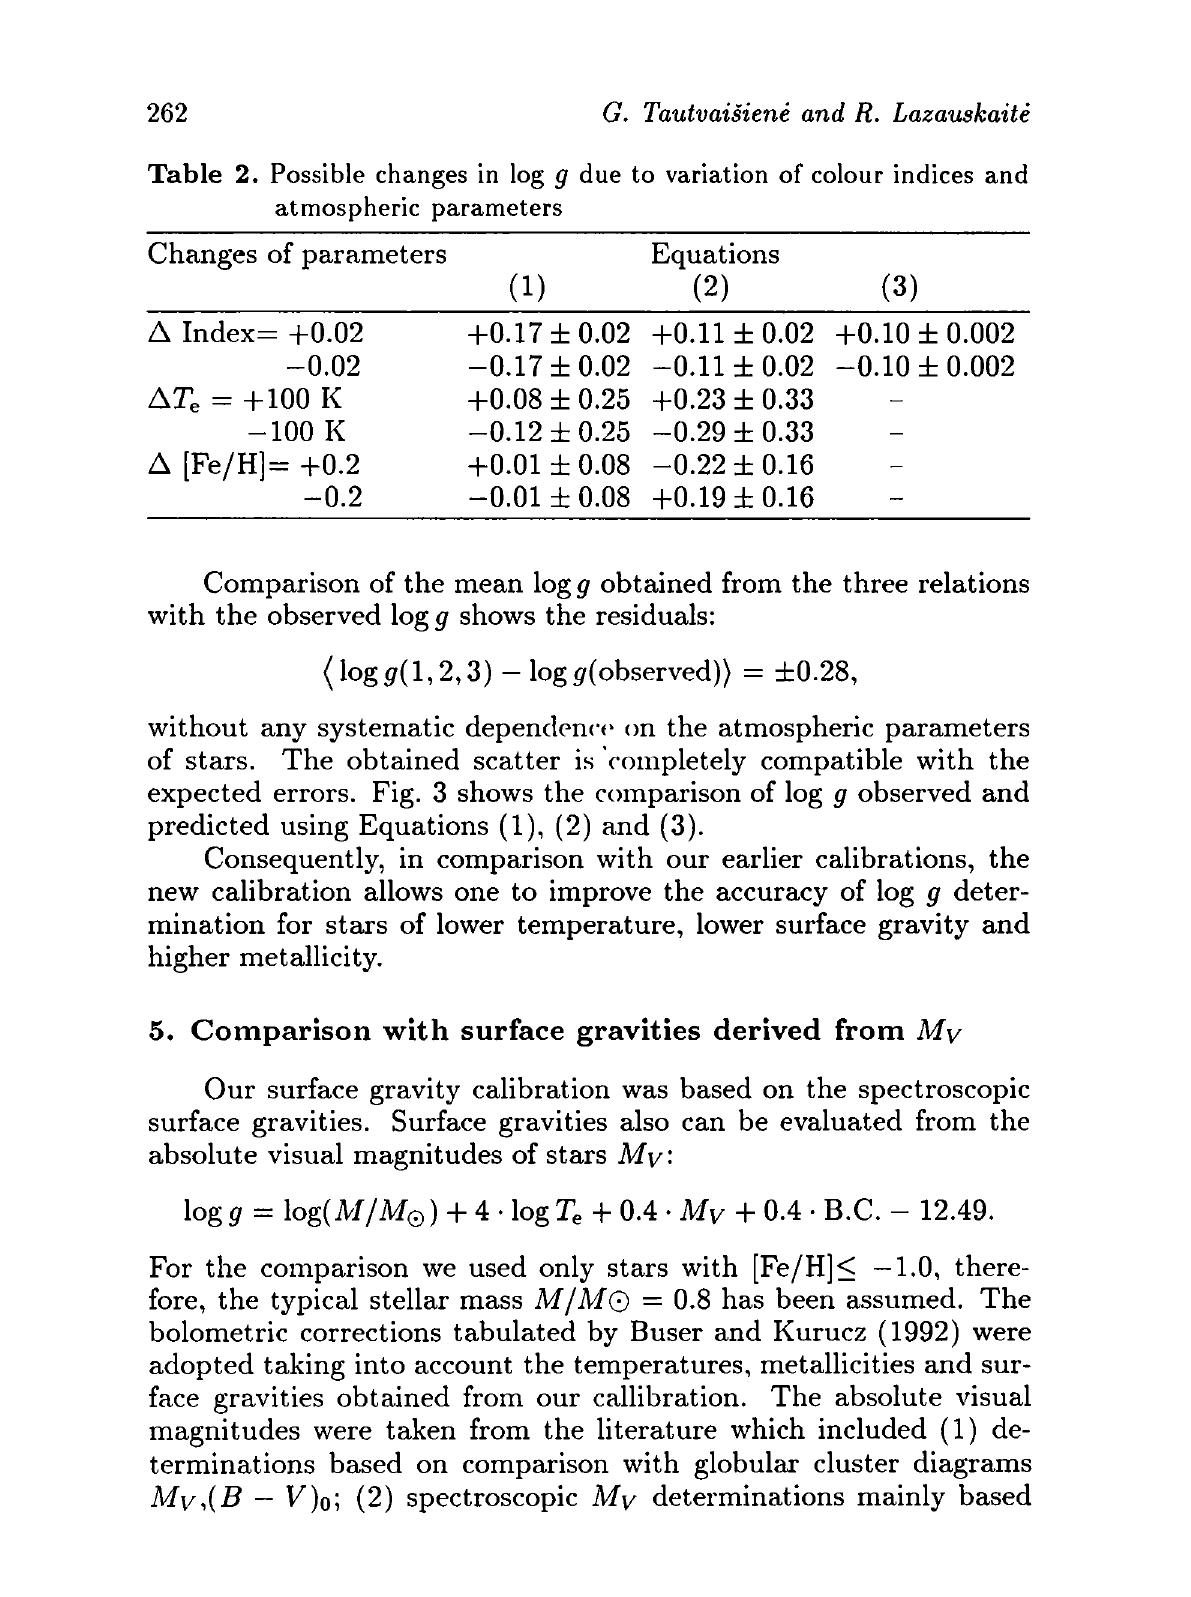
Table 2. Possible changes in log g due to variation of colour indices and atmospheric